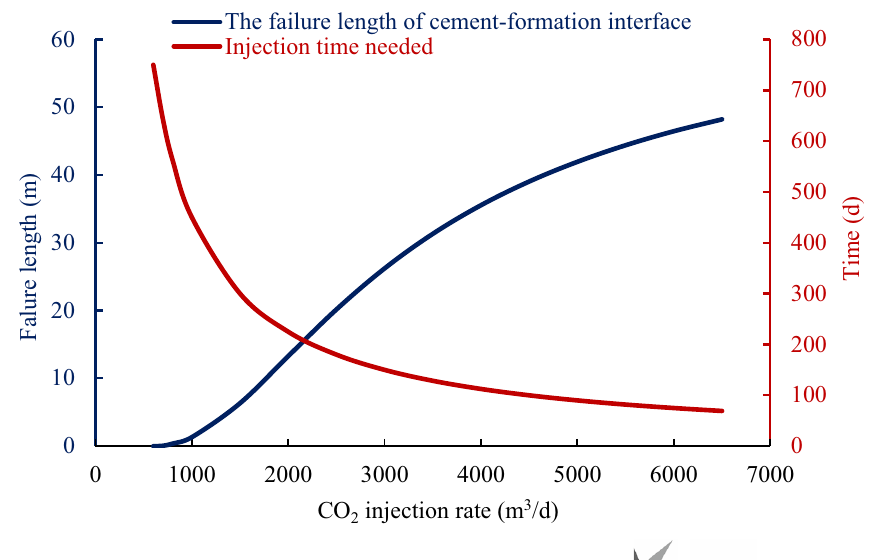
Fig. 7 Debonding failure length of cement-formation interface and the CO 2 injecting time needed under various injec- tion rates with same injecting